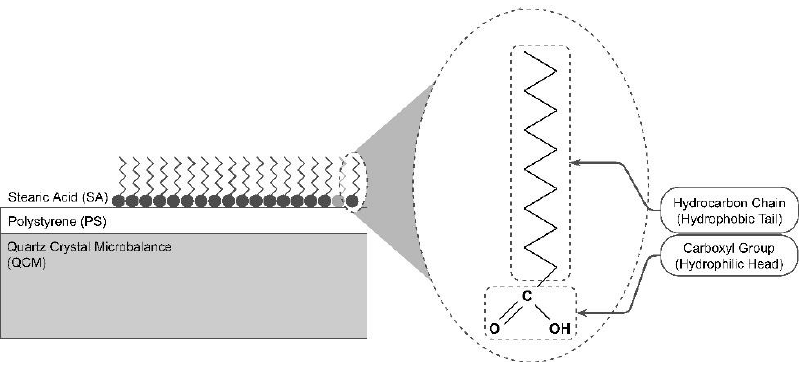
Figure 5. Illustration of the chemical reactions controlling the morphology of the stearic acid layer.